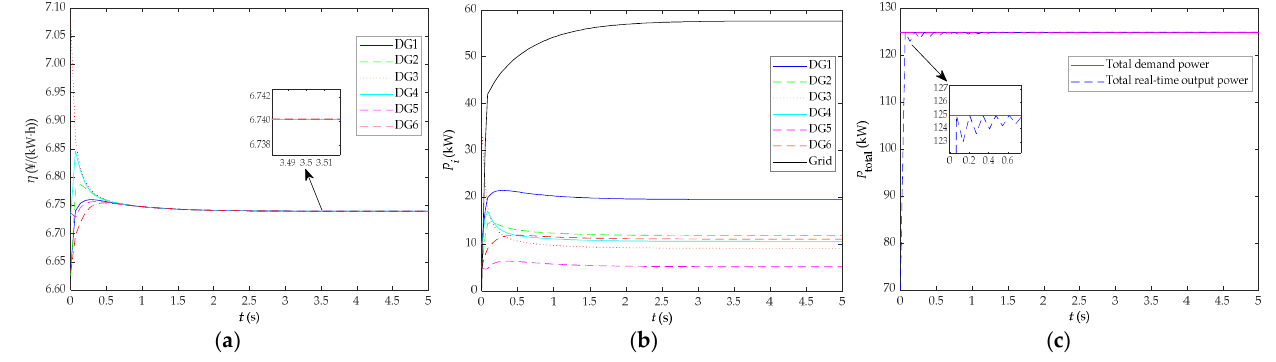
Figure 6. The change curves of variables of the system after algorithm improvement ( ζ is set as 0.1): ( a ) change curves of each DG’s ICR; ( b ) change curves of each DG’s active output and grid output power; ( c ) change curves of the cumulative sum of each DG’s active output and grid output power as well as total demand power.